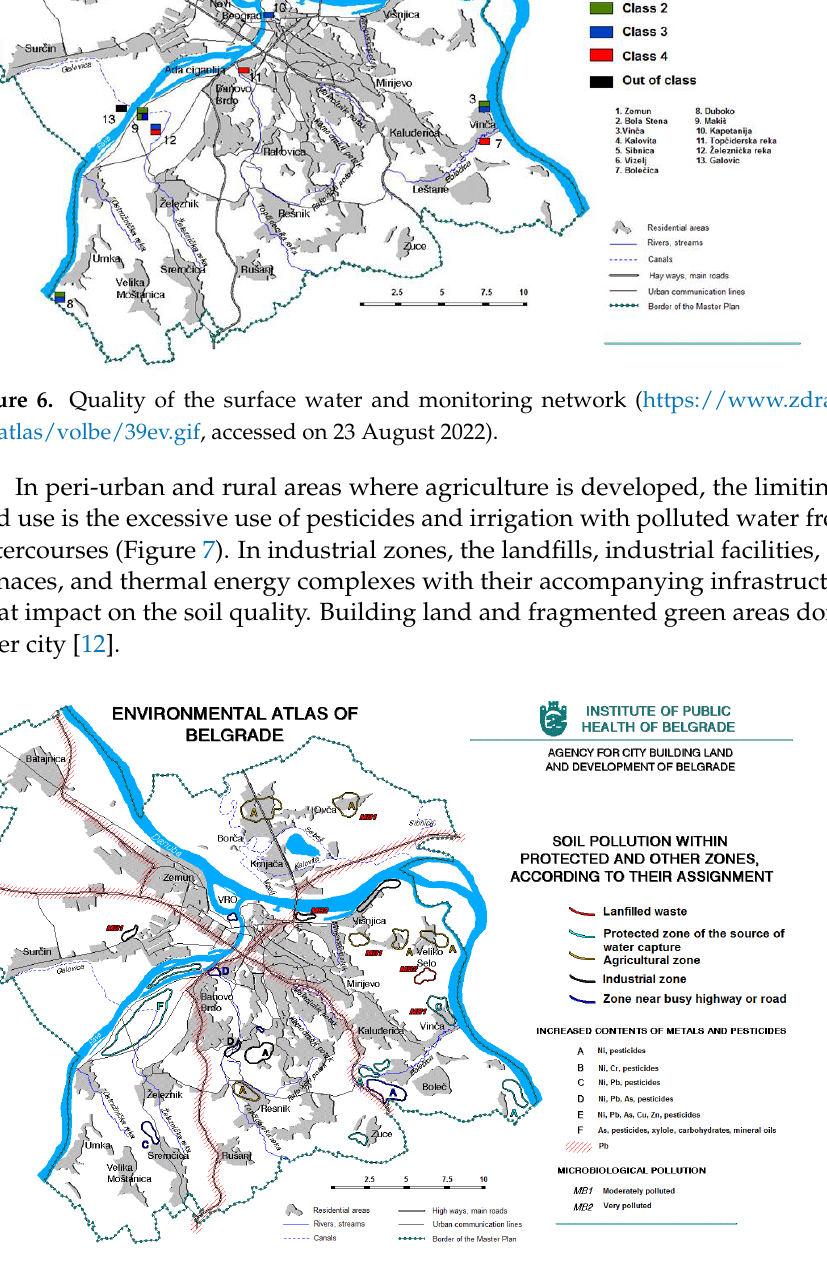
Figure 7. Soil pollution (https://www.zdravlje.org.rs/ekoatlas/volbe/45ev.gif, accessed on 23 August 2022).